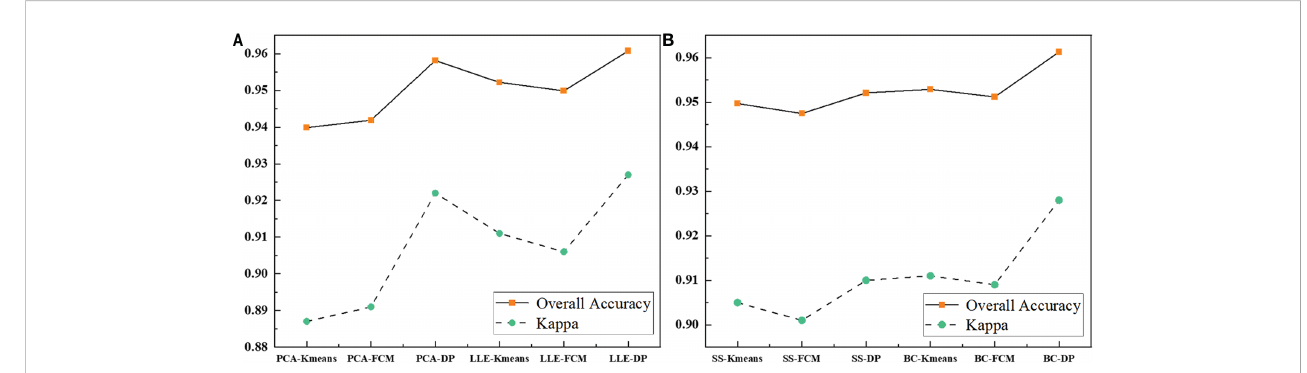
FIGURE 10 Comparison of the evaluation results of each model. (A) Comparison of the evaluation results of feature extraction models, (B) Comparison of the evaluation results of feature selection